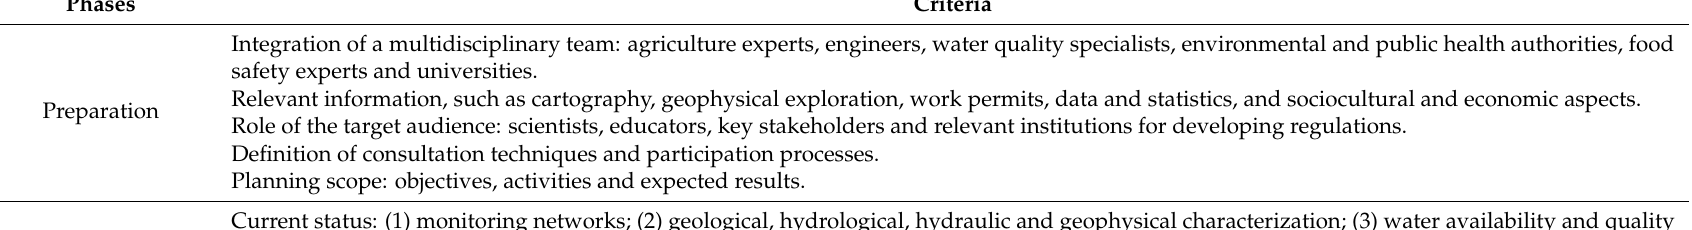
Table 3. General procedure for the use of RW in agriculture and aquifer recharge based on international guidelines [3,21–33].